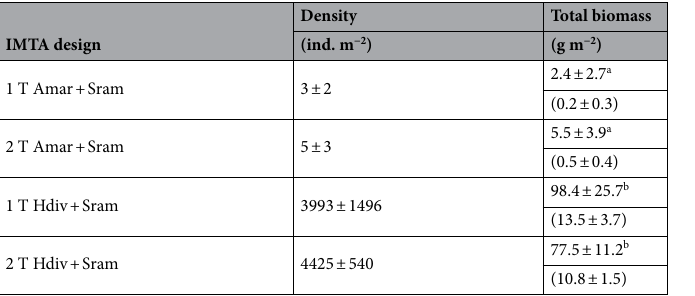
Table 2. Density and total biomass of polychaetes ( Arenicola marina —Amar—and Hediste diversicolor —Hdiv) cultured in the same tank with halophytes ( Salicornia ramosissima —Sram) (1 T) or in two separate tanks (2 T) at day 120. Average values ± SD (n = 5). Different letters indicate significant differences ( p < 0.05) between IMTA designs. The values between brackets indicate the dry weight biomass.